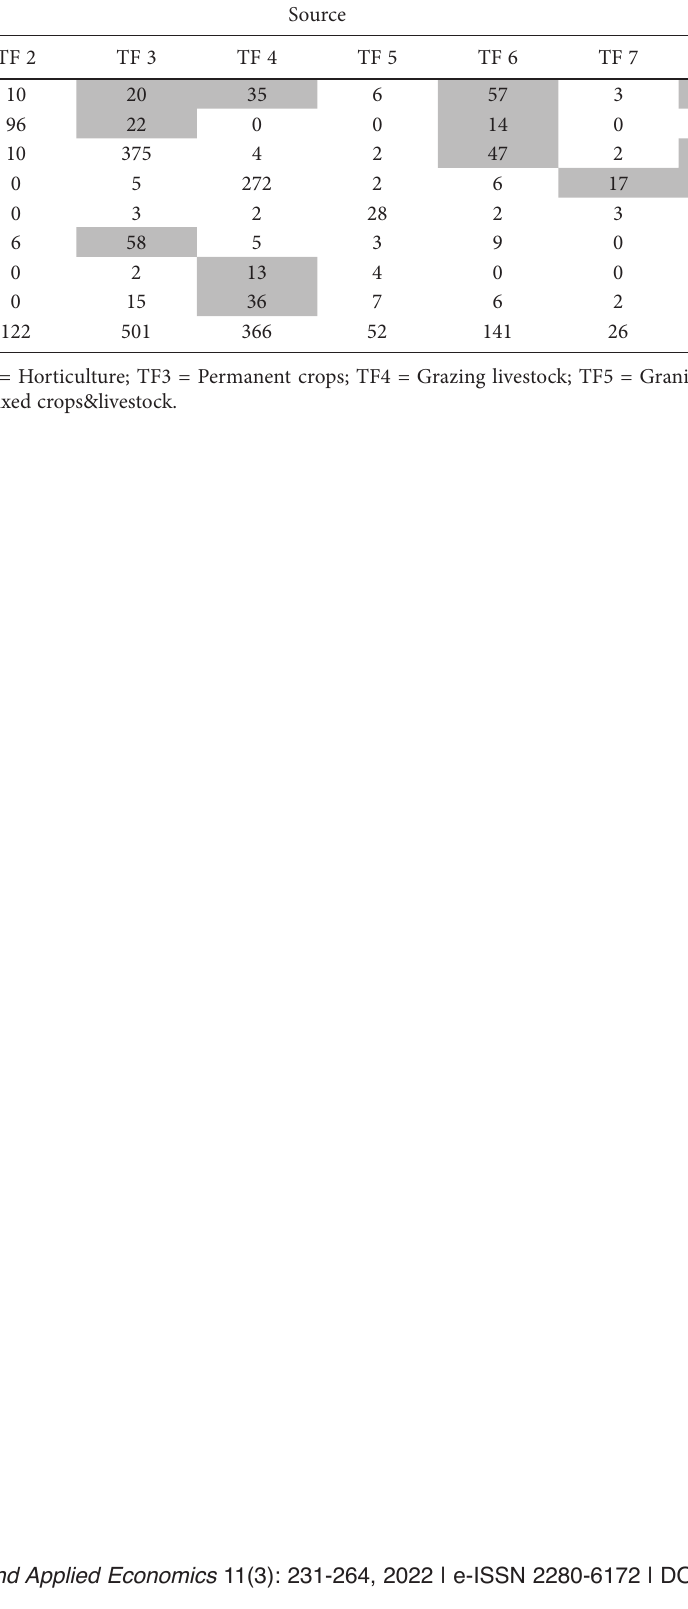
Table A3. Source-Destination matrix for TF category within the Italian 2008-2019 FADN balanced sample (in grey >10 elements). Source Destination TF 1 TF 2 TF 3 TF 4